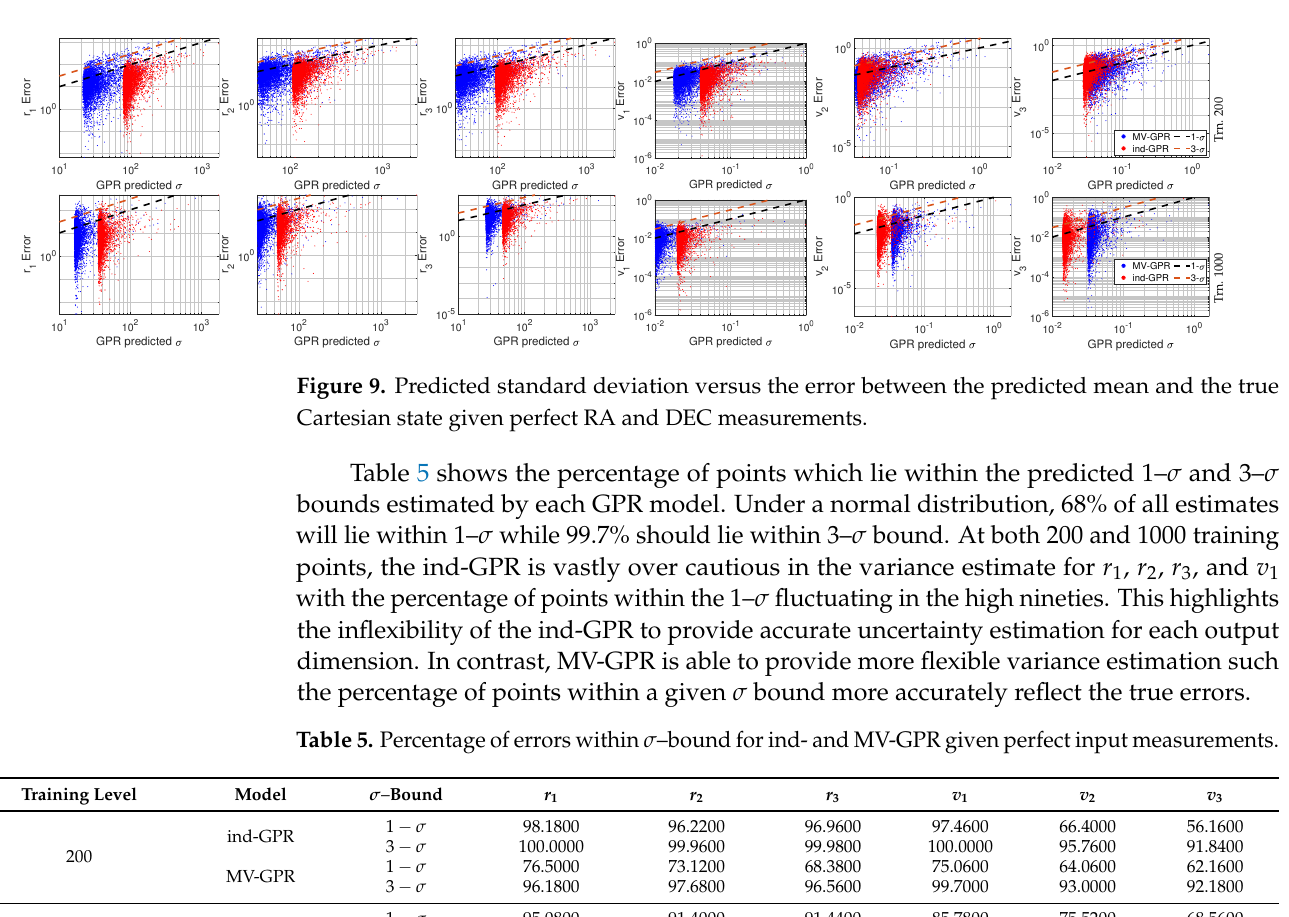
Figure 10 are plots of the true Cartesian state versus the GPR prediction error with accompanying 2- σ bounds for a random 500 point sub-sample of the 5000 test orbits for readability. Here, MV-GPR is able to better track the true error by encoding the covariance between the components of the output state. By definition, the covariance estimate in the ind-GPR algorithm is independent and identically distributed (IID) before